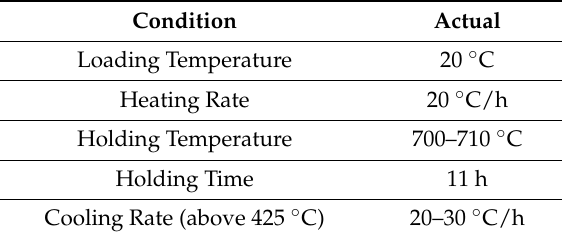
Table 2. PWHT (Post Weld Heat Treatment) conditions of Cr-Mo steel.